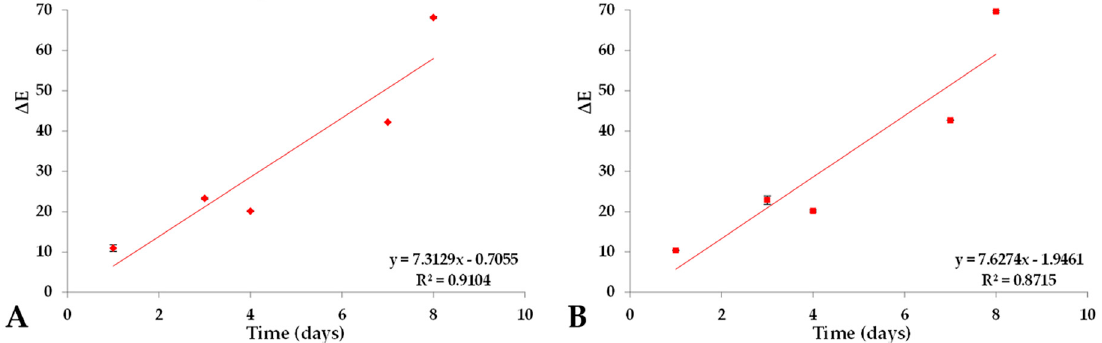
Figure 6. Color difference ( Δ E) during the stability analysis. ( A ) is a comparison between PIBP in the day 0 and next days, under light stress storage condition. ( B ) is a comparison between PIBP under light stress condition, and red-colored commercial IB (brand A).